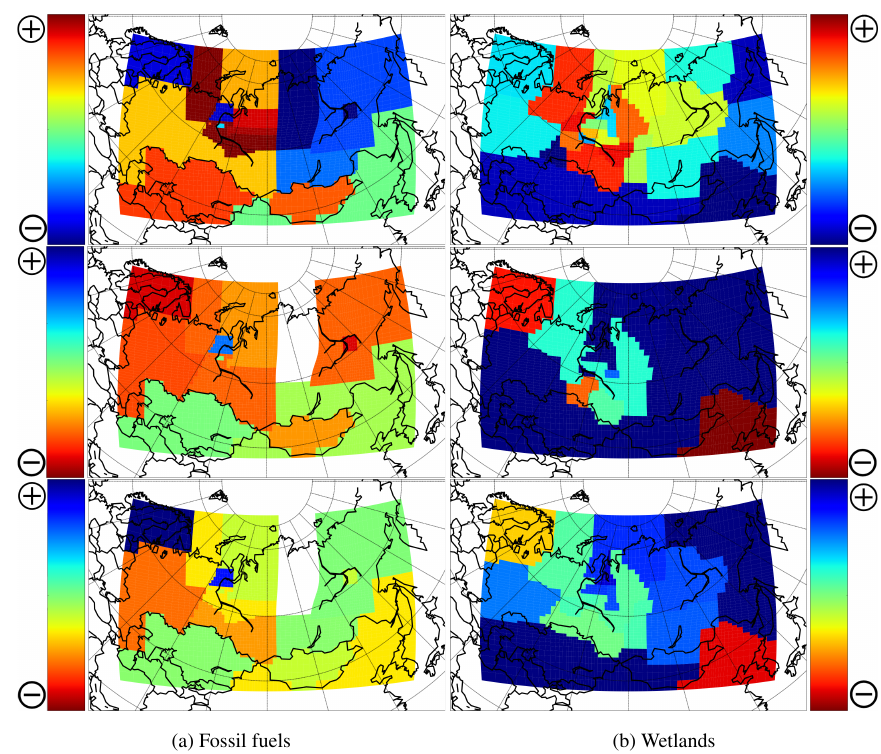
Figure 6. Map of the average scores as defined in Sect. 4.2 for OSSE 1 (see Table 1) projected on the aggregation grid defined in Sect. 3. Top: influence score z infl . Middle: relative score z rel . Bottom: absolute score z abs . The colour maps have been chosen so that redder regions correspond to better scores (denoted by (cid:9) and ⊕ symbols). The resolution and physical projection of the maps are the same as in Fig.